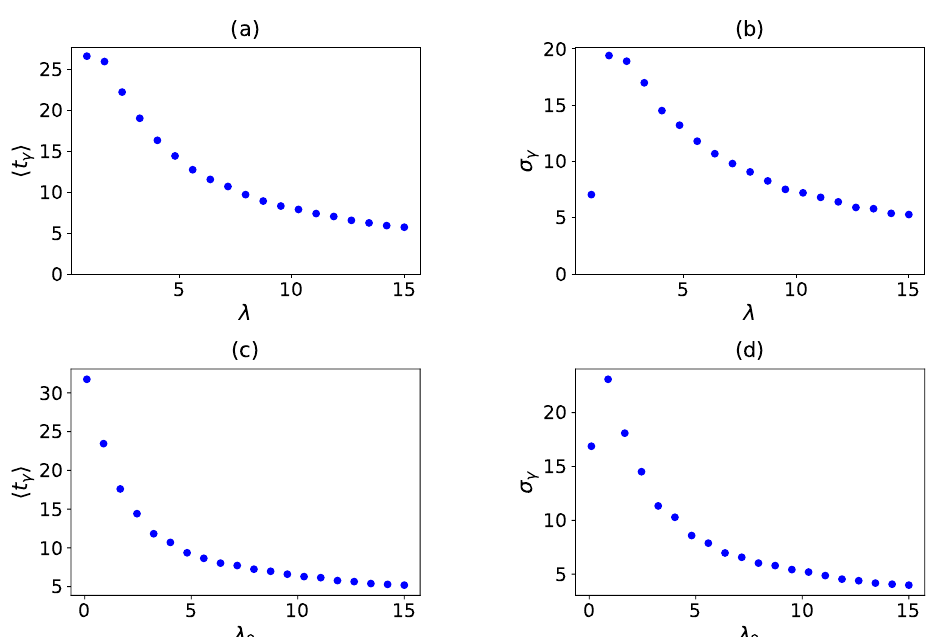
Figure 2: Panels (a) and (b) display a numerical estimate of the average value 〈 t γ 〉 (cid:113) 〈 〉 − 〈 t 〉 2 of the random variable t t 2 and the standard deviation σ γ ≡ γ γ , respec- γ tively, for the quartic oscillator, where t γ is the time at which Re ( γ ( t γ )) = 0 for the first time. We have used the Euler scheme with time step ∆ t = 2 /π × 10 − 3 to simulate the time evolution of γ with physical parameters are ω = 1, m = 10, and extracted the value of t γ for N = 10 4 trajectories. Panels (c) and (d) show the same quantities and parameters except for the presence of a time-dependent poten- tial ω 2 ( t ) = sin 2 ( t ) and λ ( t ) = λ sin 2 ( t ) . Note that, in general, 〈 t γ 〉 ∼ σ γ at large 0 values of λ : these strong fluctuations increase the probability of Re ( γ ( t γ )) = 0 at smaller values of t γ as the coupling λ